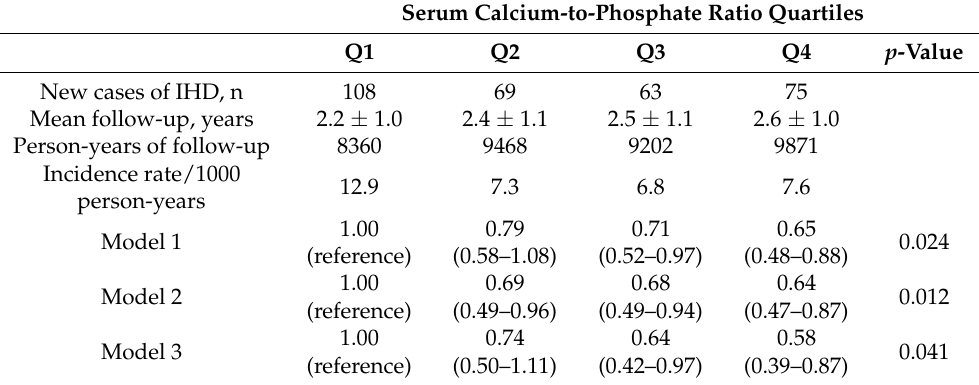
Table 5. Hazard ratios and 95% confidence intervals for new-onset ischemic heart disease (IHD) according to serum calcium-to-phosphate ratio